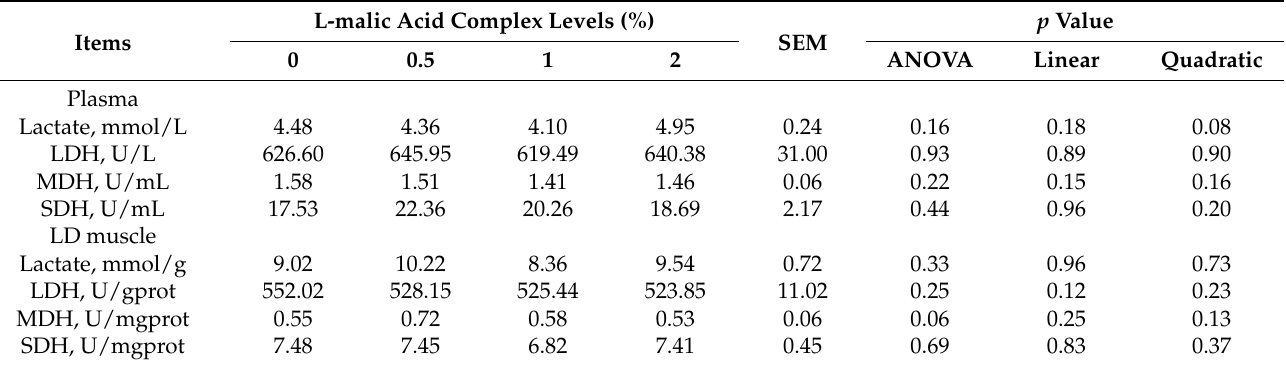
Table 7. Effects of dietary supplementation with L-malic acid on lactate content and metabolic enzyme activities of finishing pigs ( n = 8).